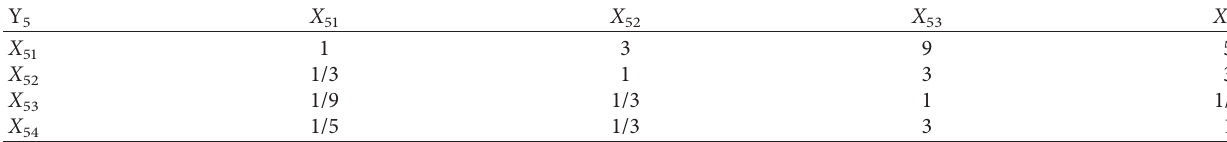
Table 9: Judgment matrix of the operation and maintenance phase.